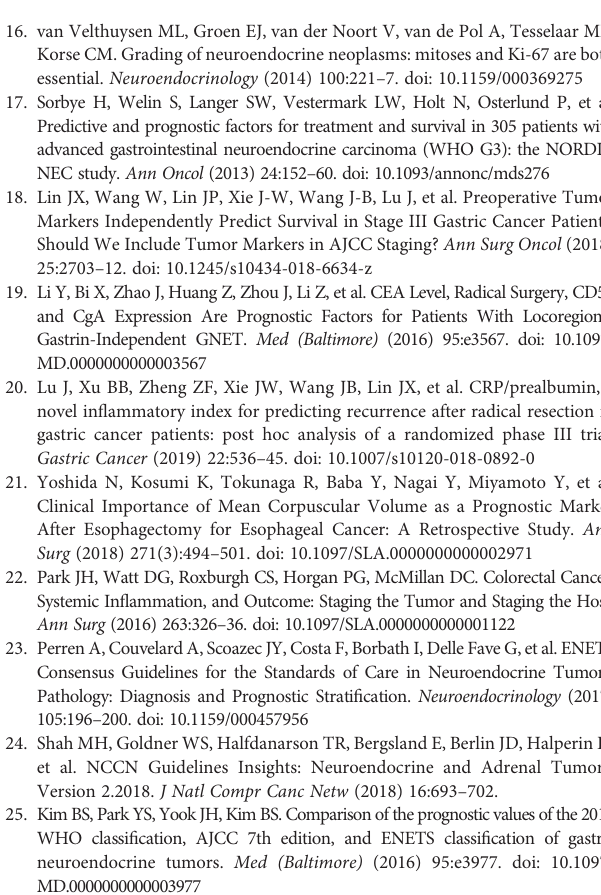
Supplementary Figure 1 | Flowchart showing the patient selection process. Supplementary Figure 2 | The (A) immunohistochemical, (B) synaptophysin and (C) chromogranin A for the diagnosis of gastric neuroendocrine carcinoma. Supplementary Figure 3 | The KC(-) group (low Ki-67 index and low carcinoembryonic antigen [CEA] levels) and the KC(+) group (high Ki-67 index and CEA levels) in the validation cohort, p = 0.002. Supplementary Figure 4 | The calibration curve of the nomogram for the validation